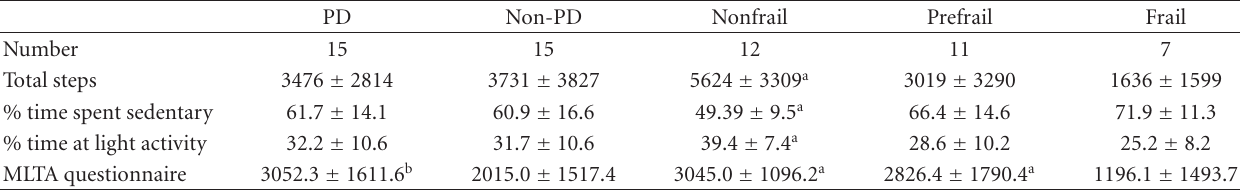
Table 2: Main e ff ects on physical activity variables.